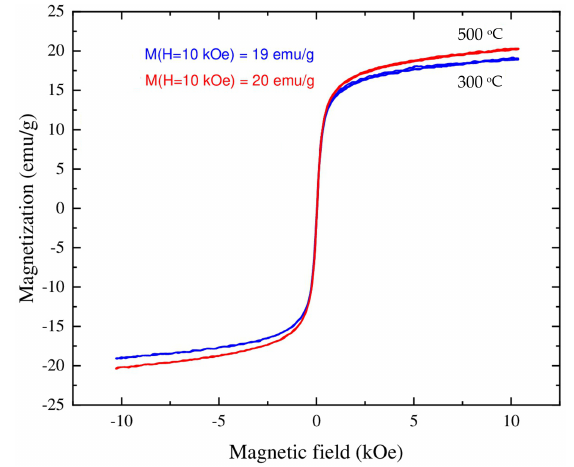
Figure 6. Magnetization curves for red muds obtained by fusion at 300 and 500 ◦ C. Figure 6 . Magnetization curves for red muds obtained by fusion at 300 and 500 °C.